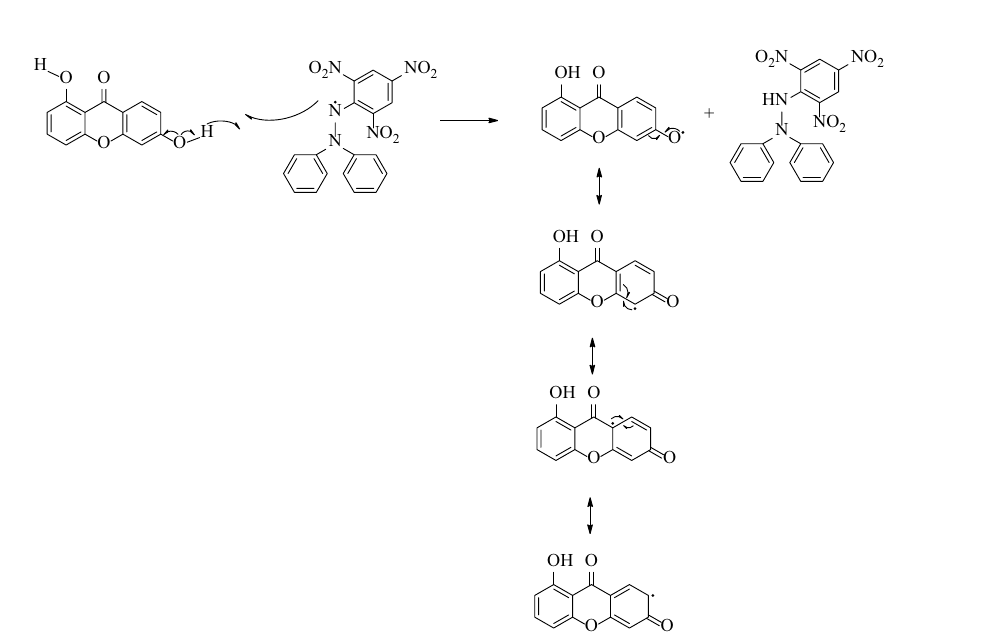
Figure 2. The plausible reaction of DPPH free radical with dihydroxyxanthone 3b .